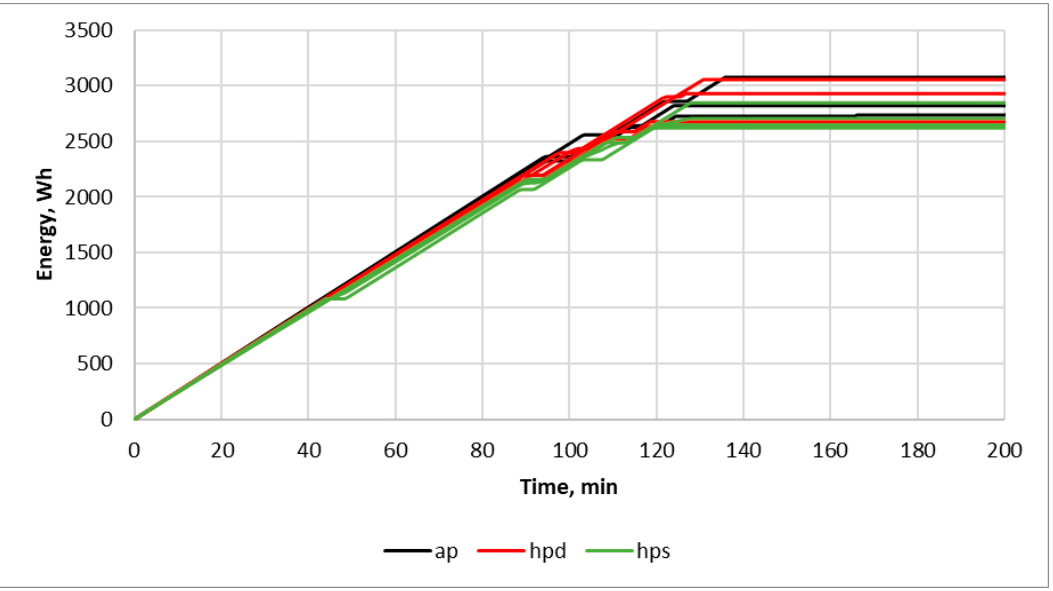
Figure 9. Cumulative energy demand for the torrefaction process.